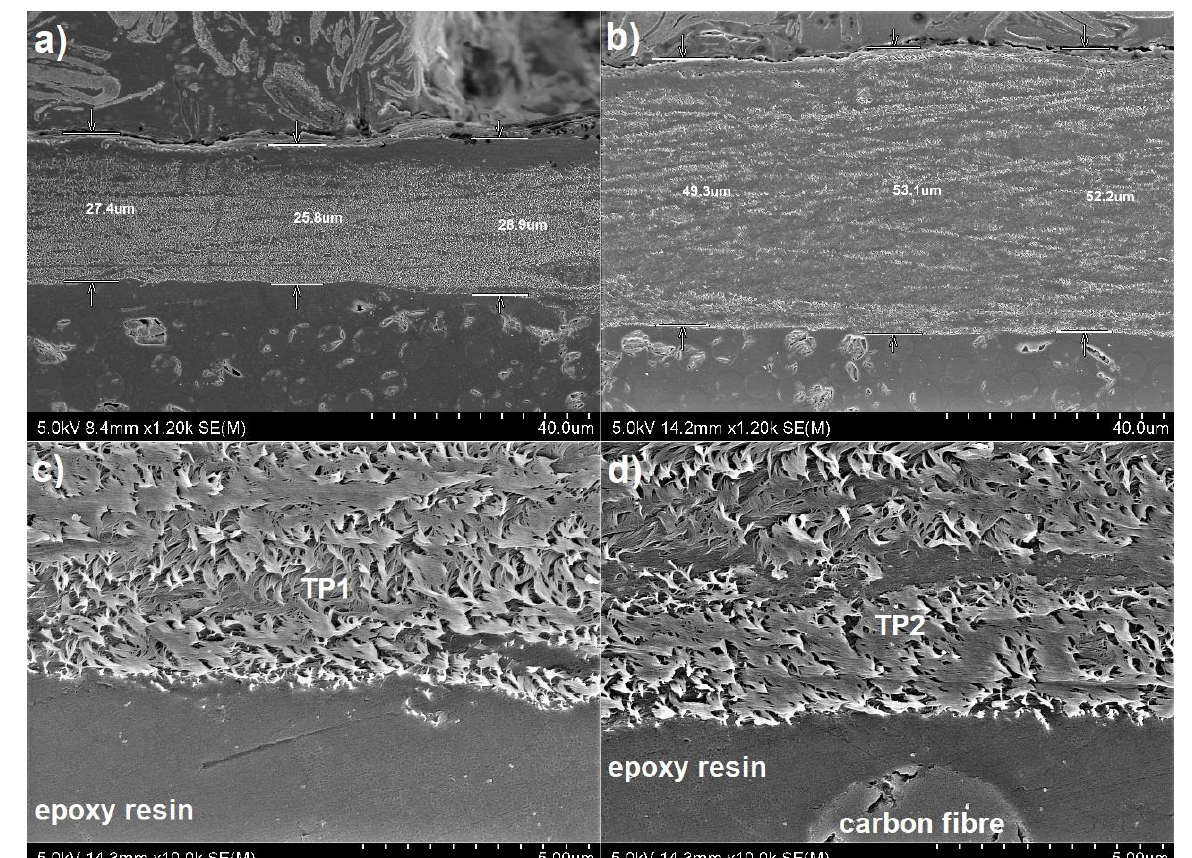
Figure 8. Microstructure of the cross-section of laminates with Tuball paper on the top: ( a ) and ( c )—L2; ( b ) and ( d )—L3. The arrow shows epoxy resin inside the layer.